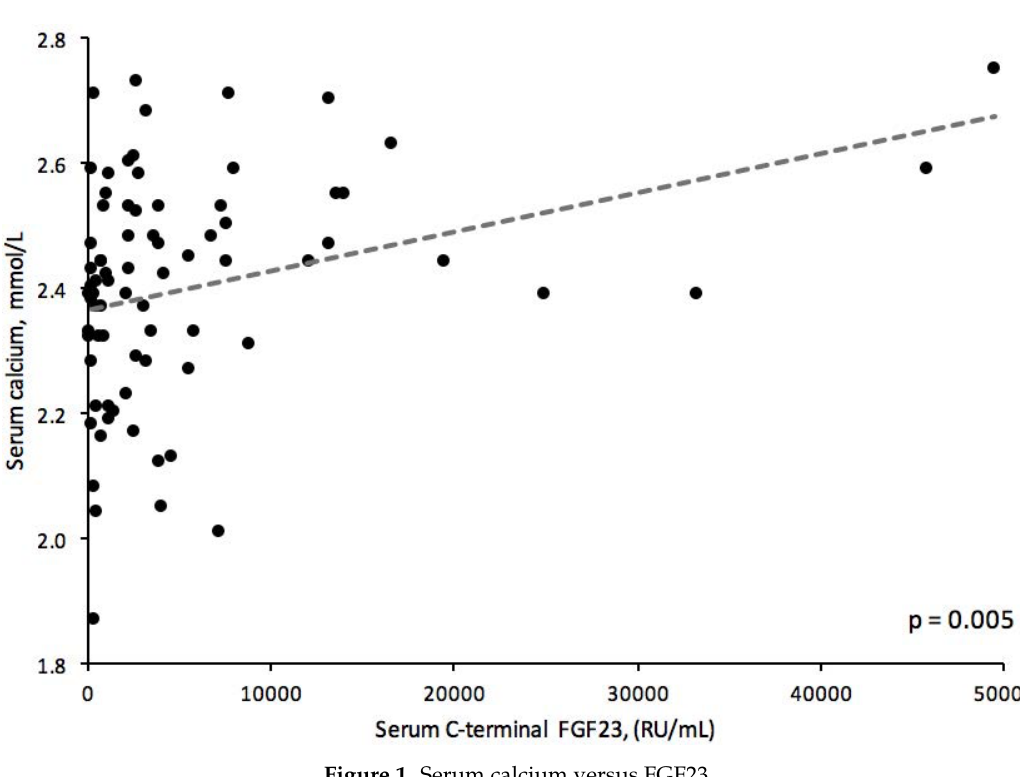
Figure 1. Serum calcium versus FGF23.